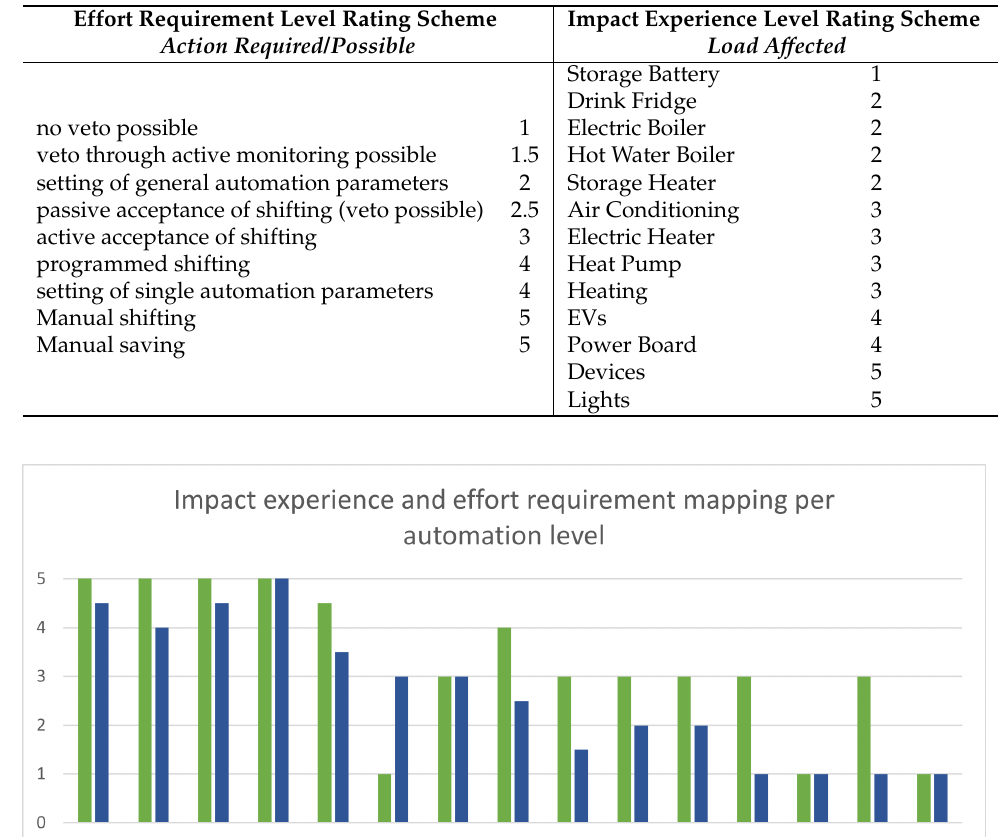
Table 2. Effort requirement and experience impact rating scheme.